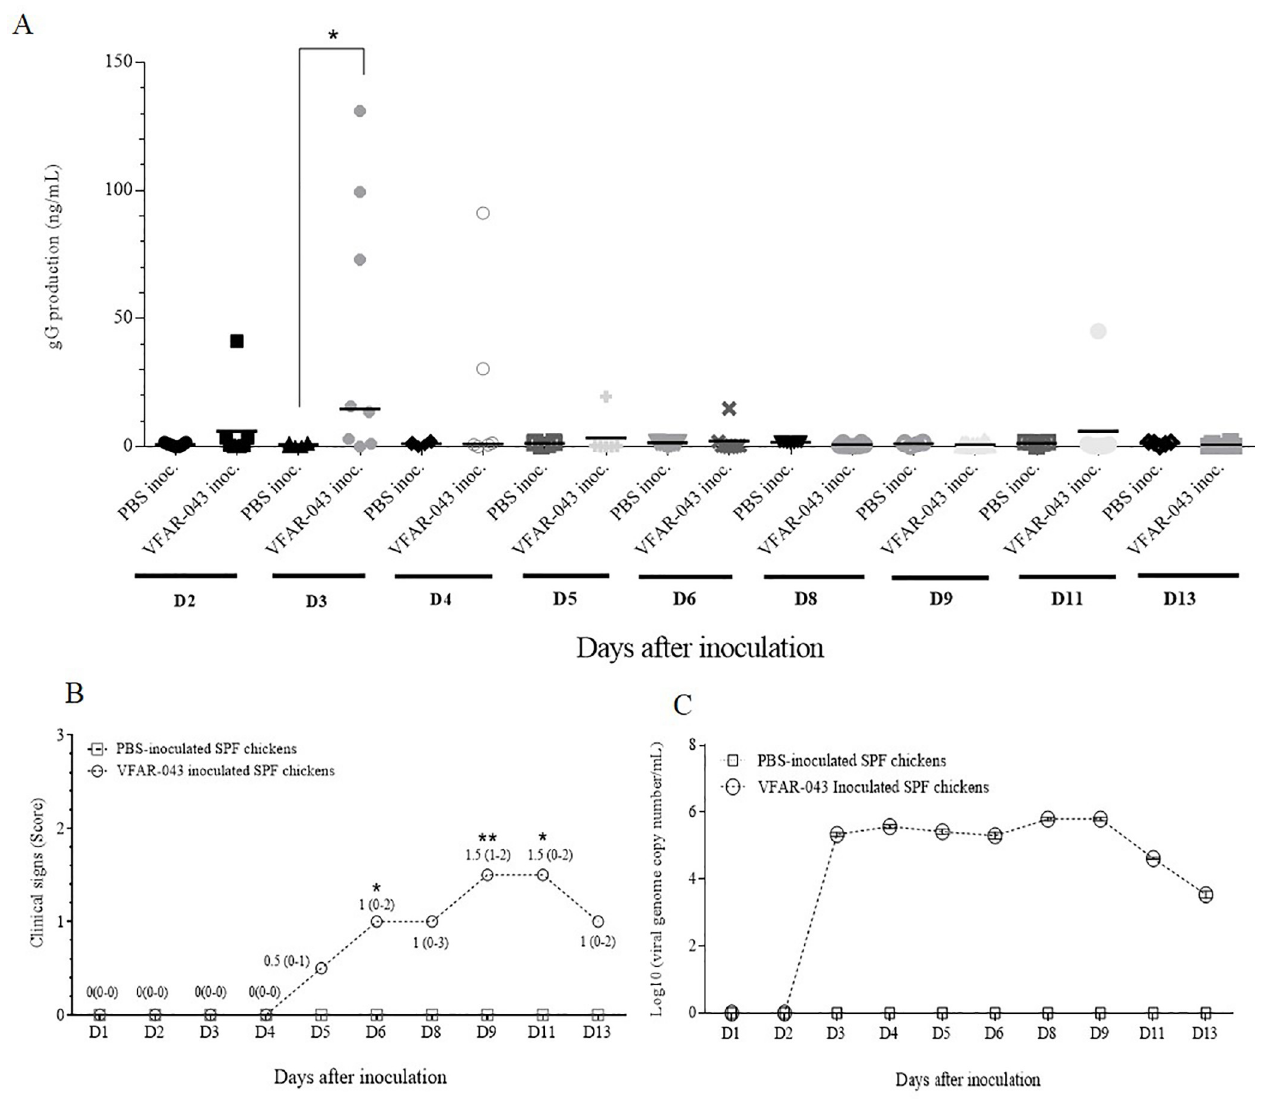
Fig 8. Relationship among the gG production profile in tracheas (A), the clinical sign scores (B) and viral genome copy number in tracheas (C) from VFAR-043 inoculated SPF chickens. PBS inoc.: PBS-inoculated SPF chickens; VFAR-043 inoc.: VFAR-043 inoculated SPF chickens. (A): the horizontal lines indicate the median value for each group. (B): only numerical values for medians and ranges are shown for VFAR-043 inoculated SPF chicken and all medians for PBS-inoculated SPF chickens were zero. (C): Each point represents daily sample pooling for each group. All values were expressed as a log10 (viral genome copy numbers/mL). The Mann–Whitney U test was performed for analyses. � = p < 0.05; �� = p < 0.005.